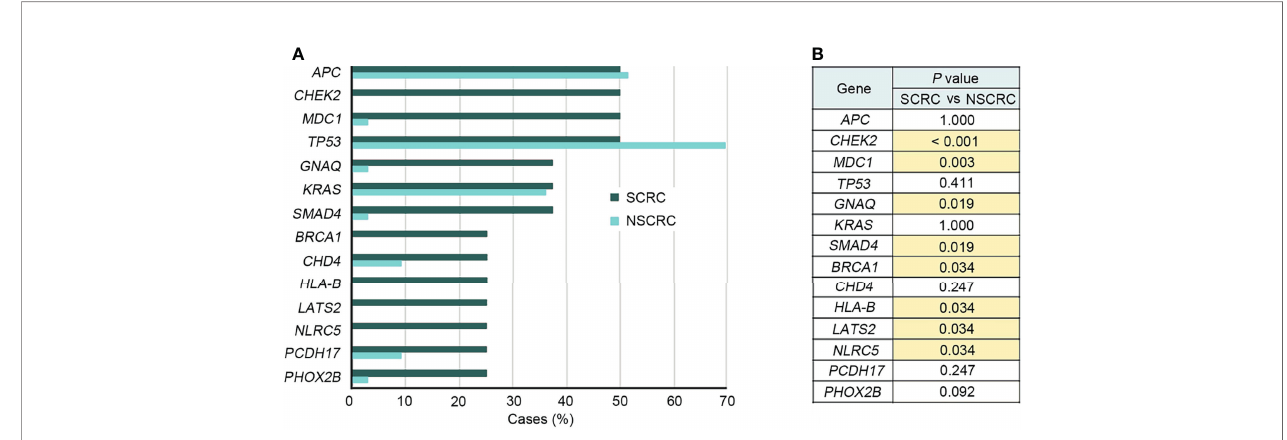
FIGURE 3 | Comparison of the genomic landscape between SCRC and NSCRC cohorts. (A) Frequencies of genomic mutations in SCRC and NSCRC cohorts. (B) Corresponding P values comparing the prevalence of a gene ’ s mutations between different cohorts. Cases with a statistically signi fi cant difference ( P < 0.05) are highlighted in yellow.